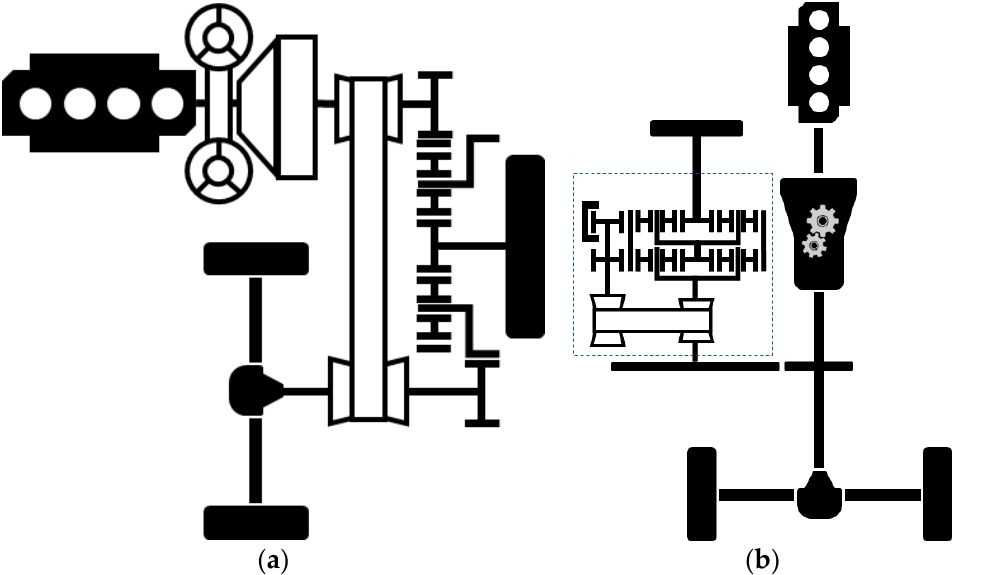
Figure 1. Flywheel hybrid vehicle schematic with ( a ) two-degrees-of-freedom [18], and ( b ) three- degrees-of-freedom [10].